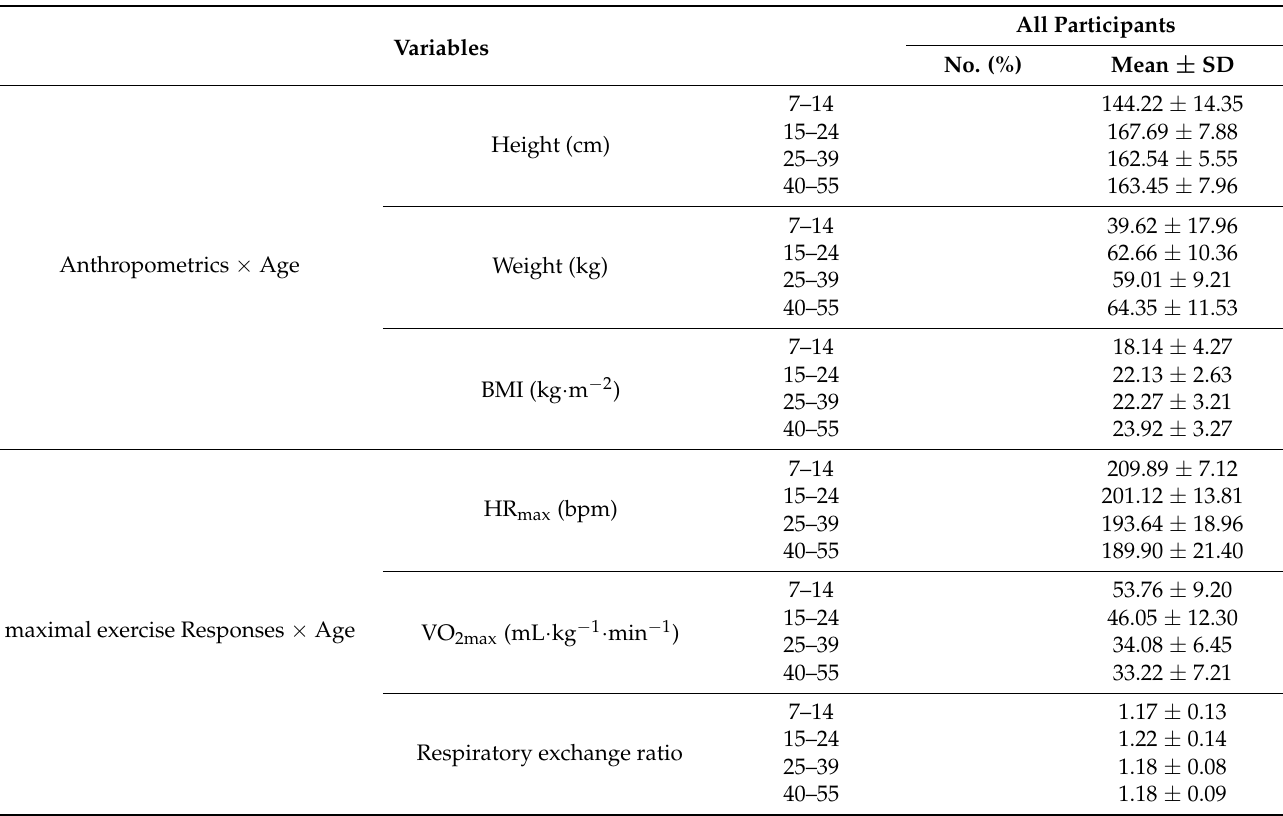
Table 1. Participants’ characteristics (n =